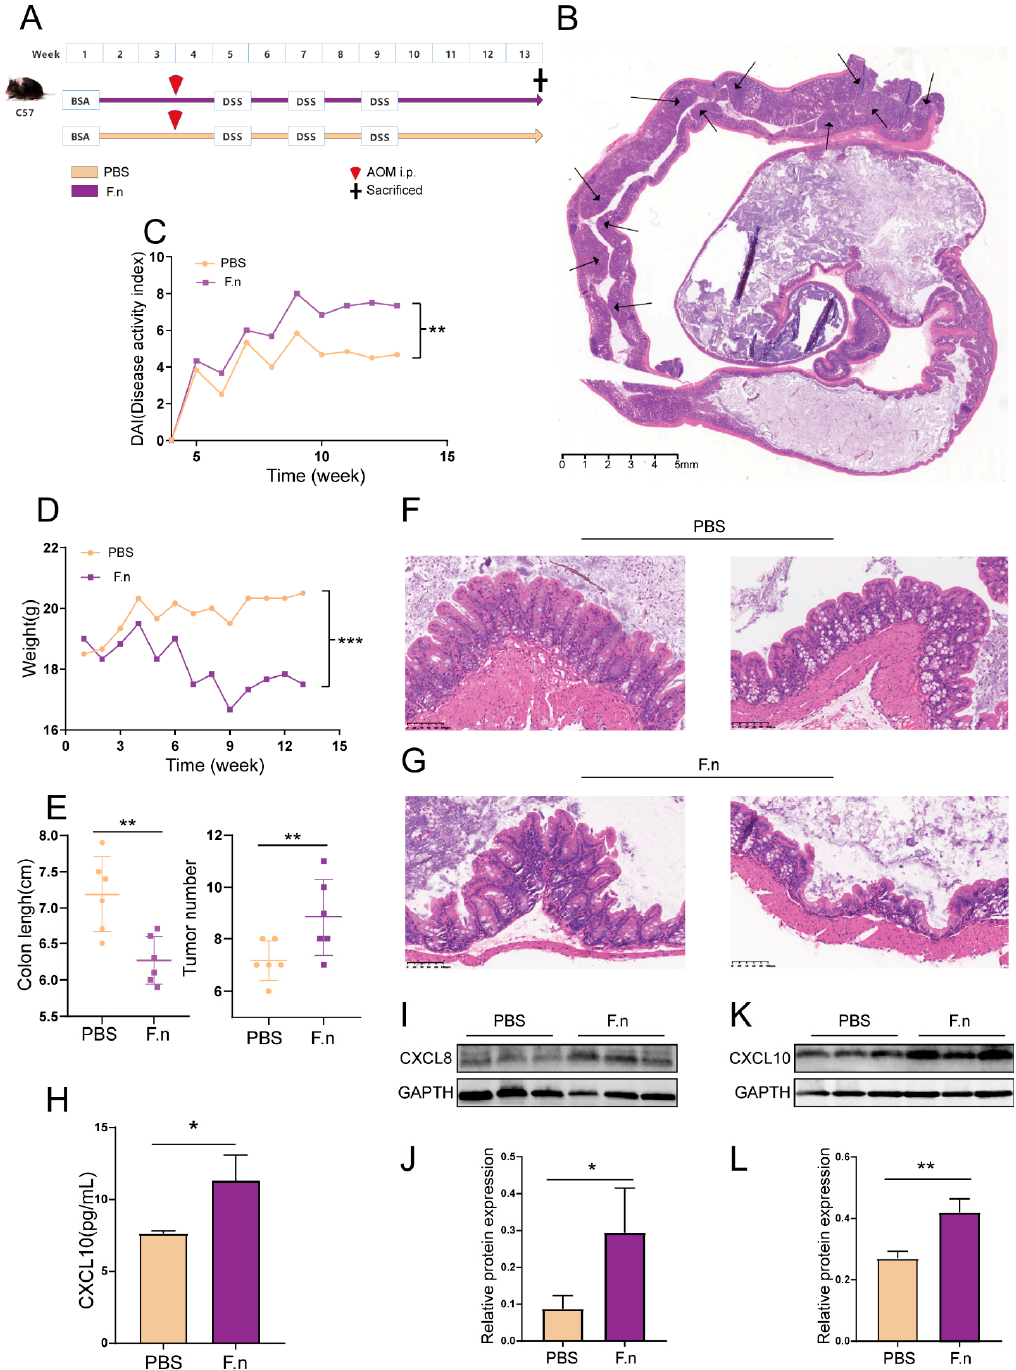
Figure 12. Treatment with F. nucleatum aggravates inflammation of the intestine, promotes tumorigenesis, and increases CXCL8 and 10 gene expression in AOM/DSS-induced CAC mice. ( A ) Timeline of the experimental schedule. ( B ) Representative images of H&E staining of the Swiss roll section of the colon segment. Changes in ( C ) disease activity index (DAI) and ( D ) body weight during a period of 13 weeks. ( E ) Colon length and tumor number of F.n-treated and PBS-treated mice. ( F , G ) Representative images of H&E staining of colon tissue ( × 200; scale bar, 100 µ m). ( H ) Serum CXCL10 levels were evaluated by ELISA. ( I – L ) WB showed an increase in CXCL8 and 10 protein levels in the colon tissue of F. nucleatum -treated mice.Data are presented as means ± SD. * p < 0.05; ** p < 0.01; *** p < 0.001; Student’s t -test (two-tailed). The original Western blot images of ( I & K ) was shown in Material